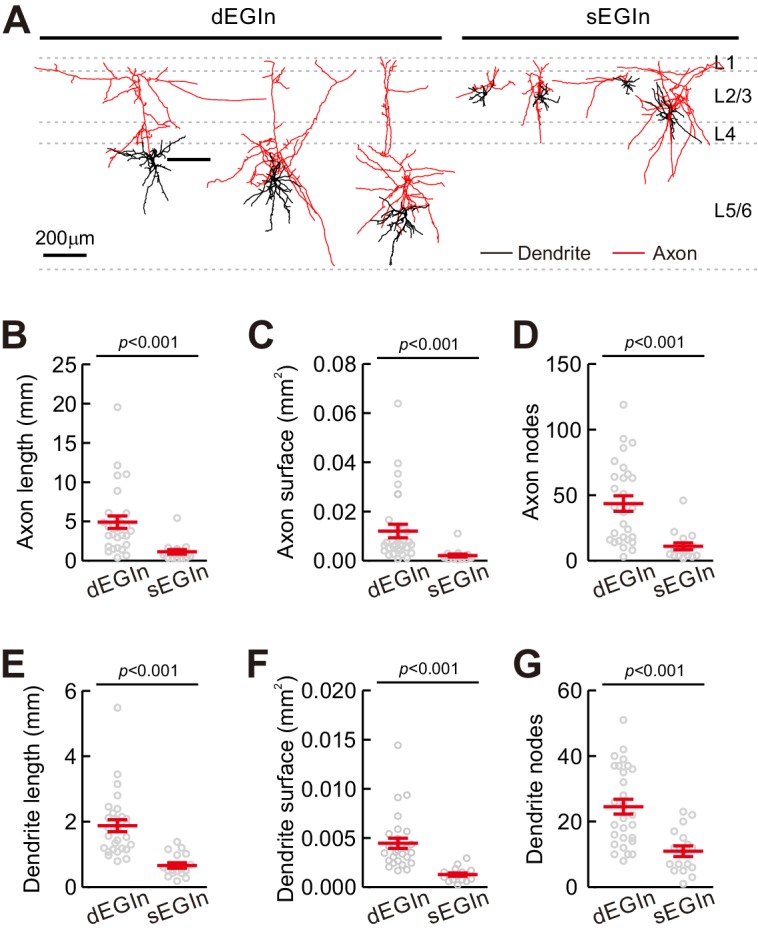
Morphological properties of dEGIns and sEGIns at P5–7.(A) Morphological samples of dEGIns (left 3 cells) and sEGIns (right 4 cells) in the somatosensory cortex. Scale bar, 200 μm. (B–G) Comparison of axon length (B), axon surface (C), axon nodes (D), dendrite length (E), dendrite surface (F) and dendrite nodes (G) between dEGIns and sEGIns. Detailed statistical analysis, detailed data and exact sample numbers are presented in the Figure 2—source data 1. Error bars indicate mean ± SEM.